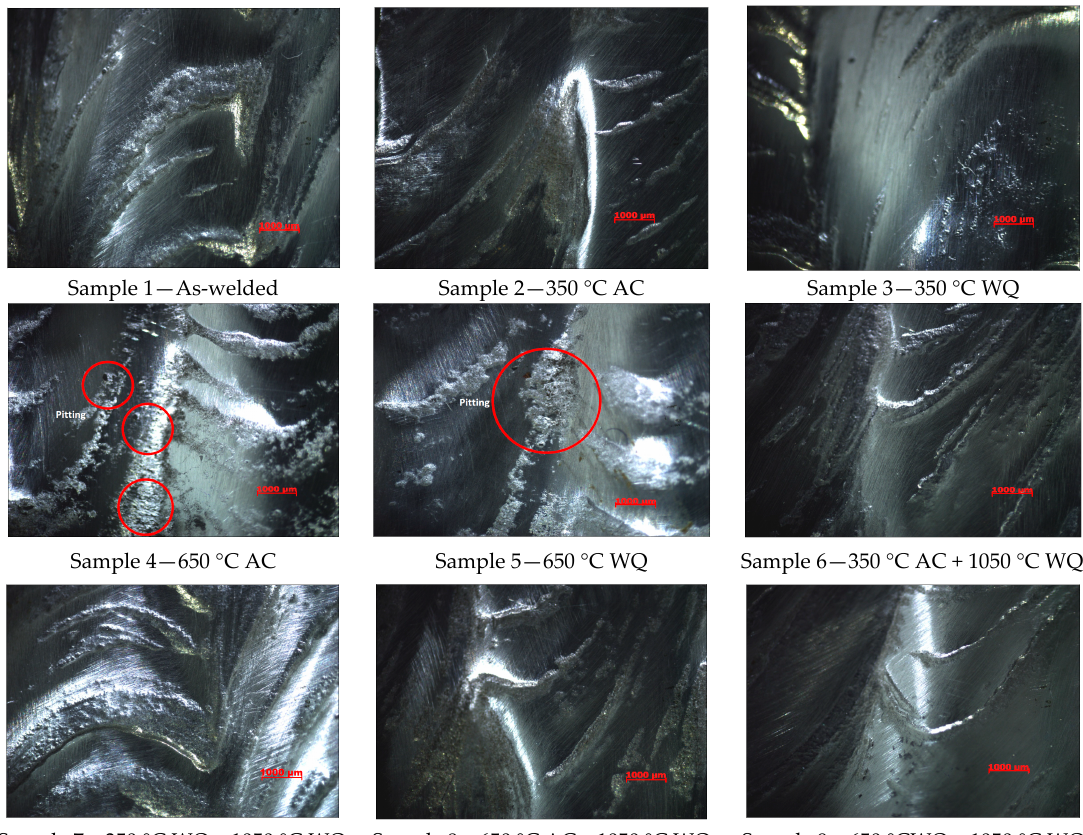
Figure 2. Pits morphology with optical image at 20× magnification.